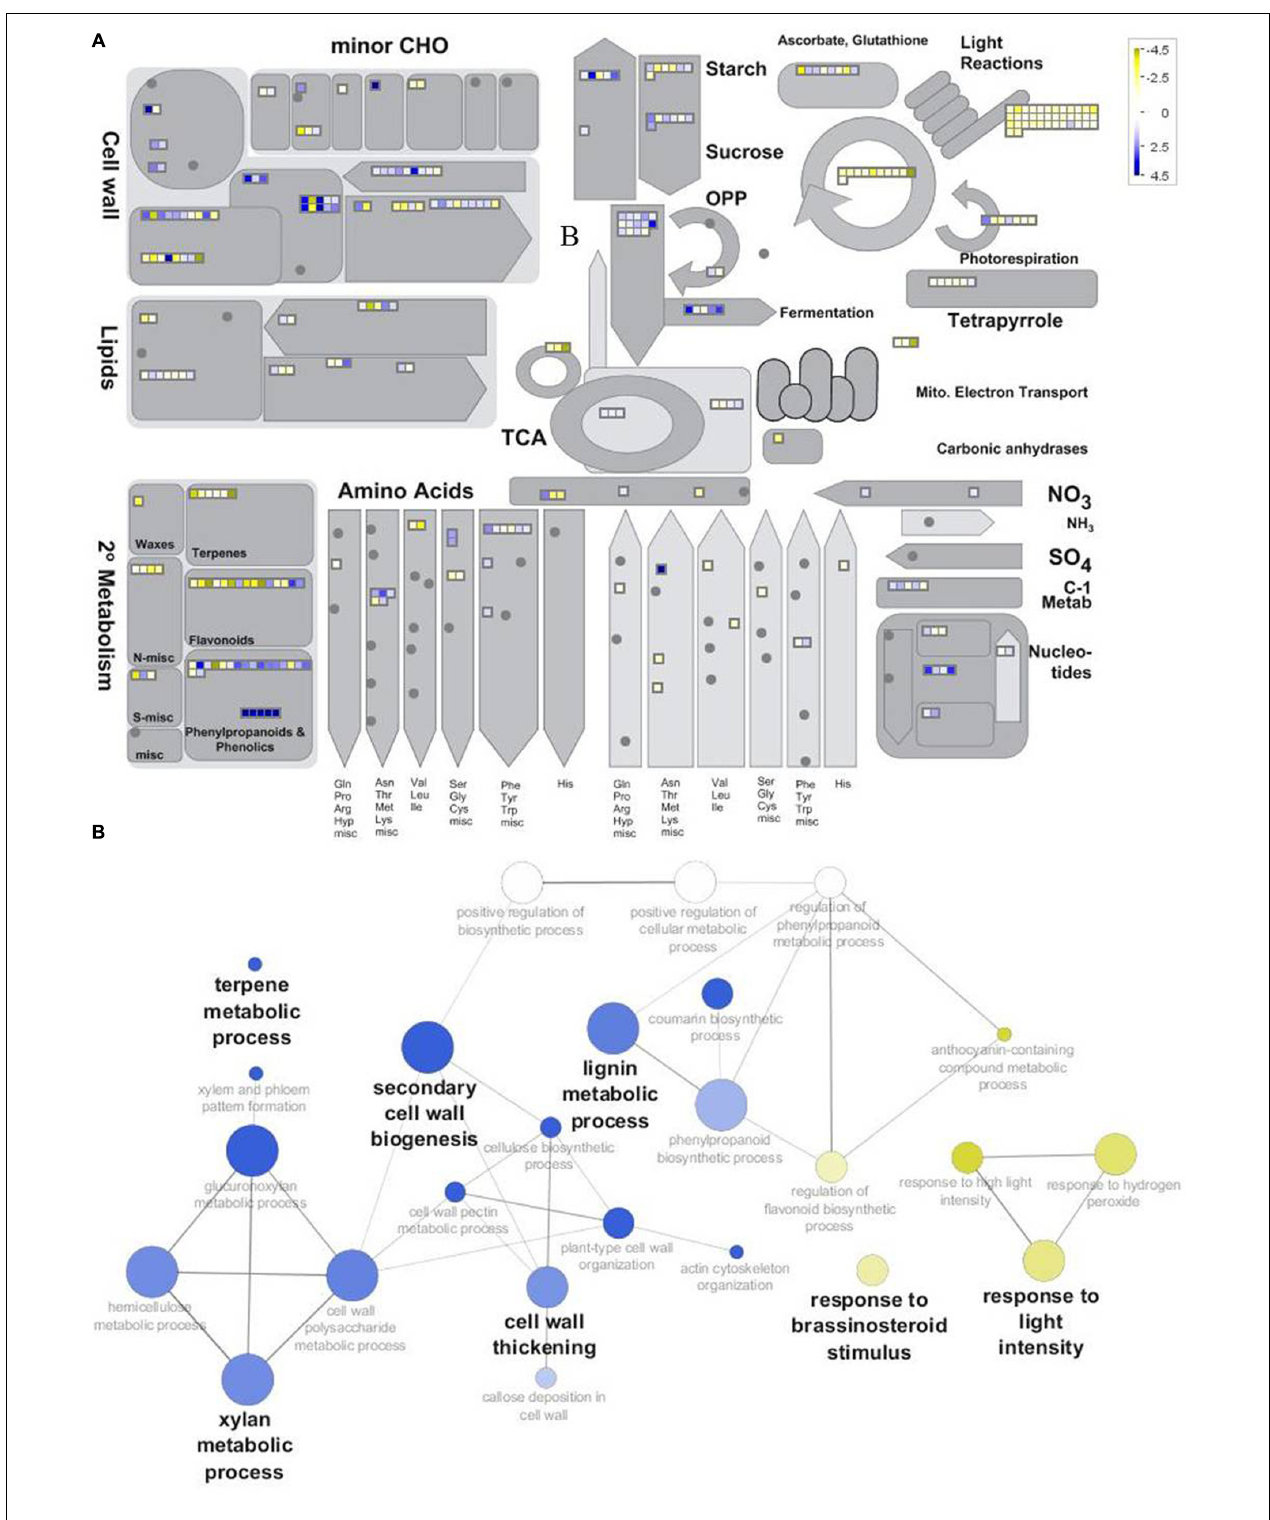
FIGURE 7 | Overview of the differentially expressed genes between H6 and H20. (A) Top: Metabolism overview provided by MapMan functional annotation. Genes up-regulated in H6 and H20 are represented by yellow and blue squares, respectively. (B) Bottom: GOE performed with the subset of genes showing − 2 > log 2 FC (H20/H6) > 2 in Cytoscape using ClueGO and CluePedia. Biological processes with genes overrepresented in H6 and H20 are shown in yellow and blue , respectively.